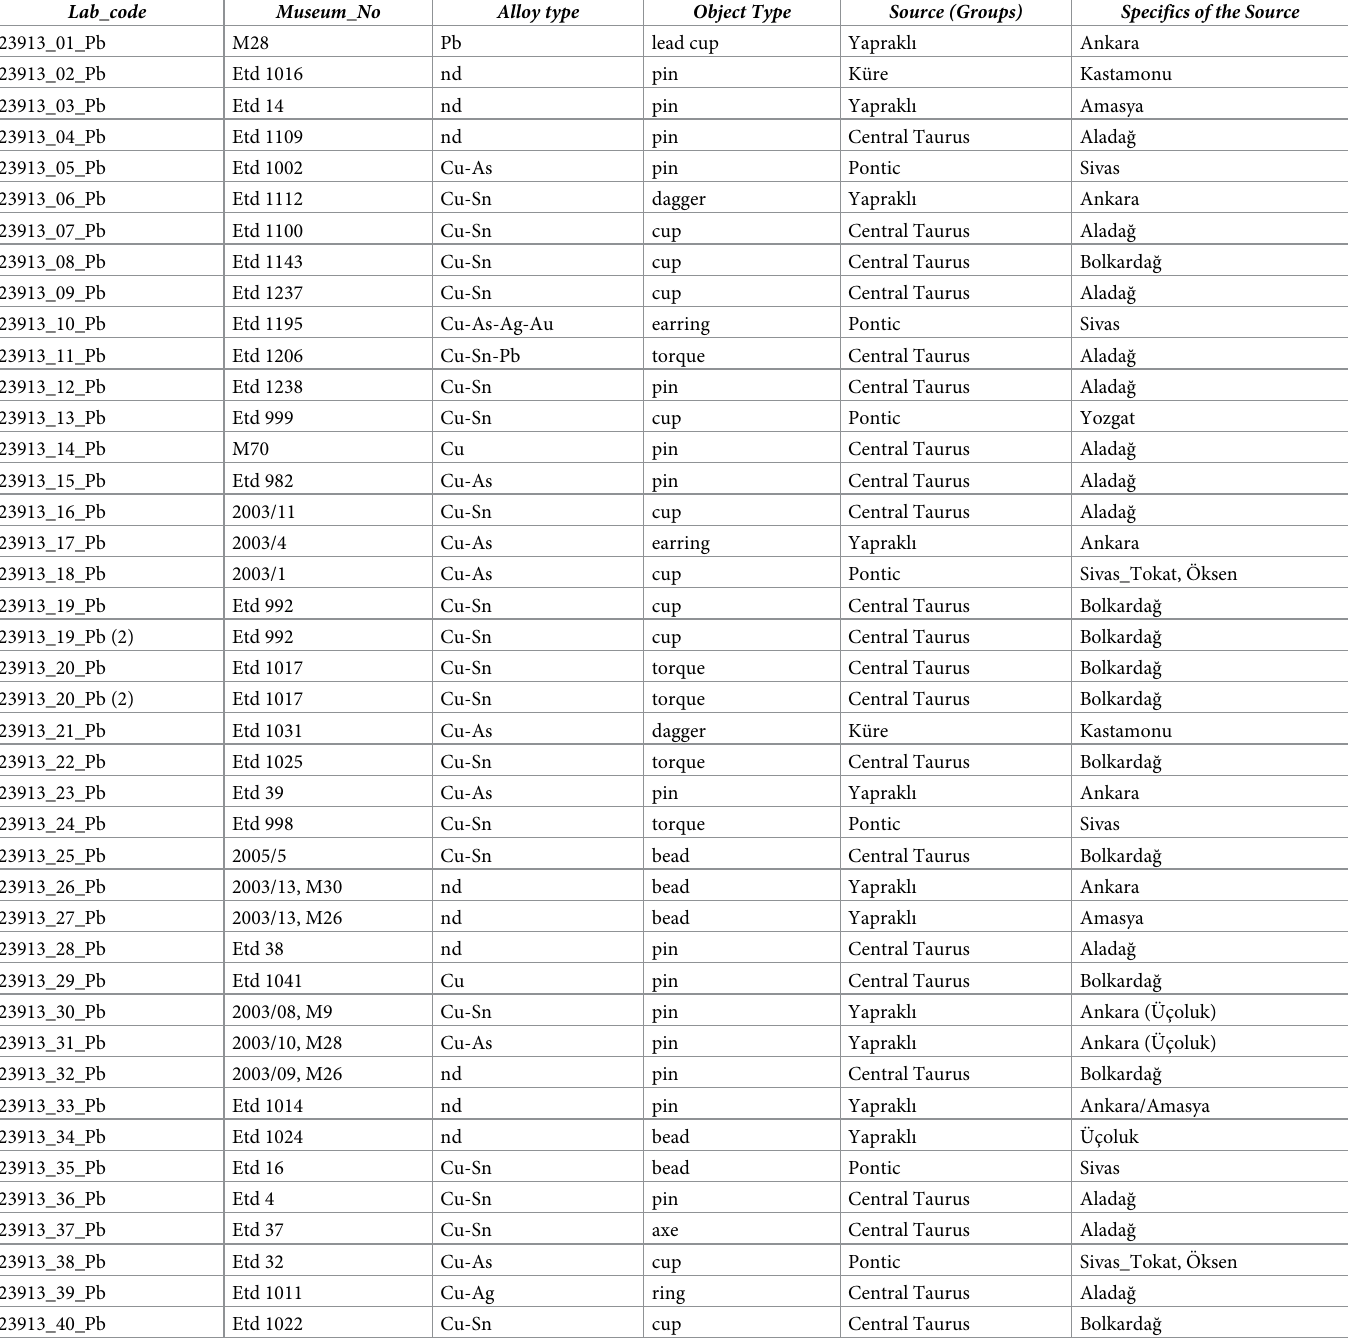
Table 3. Suggested provenance of the Resulo ğ lu metals based on the lead isotope analysis.